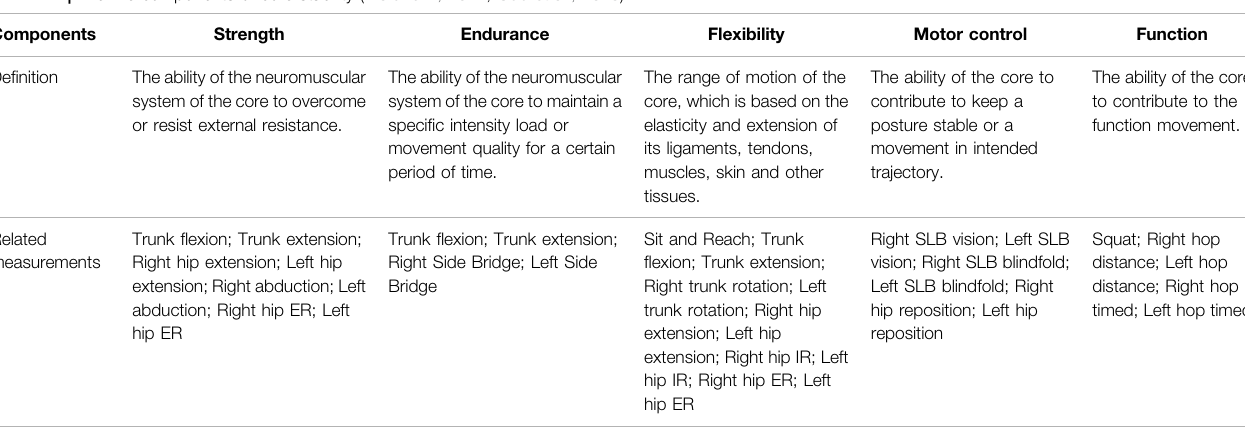
TABLE 1 | The fi ve components of core stability (Waldhelm, 2012; Guo et al., 2019) Components Strength Endurance Flexibility Motor control Function De fi nition The ability of the neuromuscular system of the core to overcome or resist external